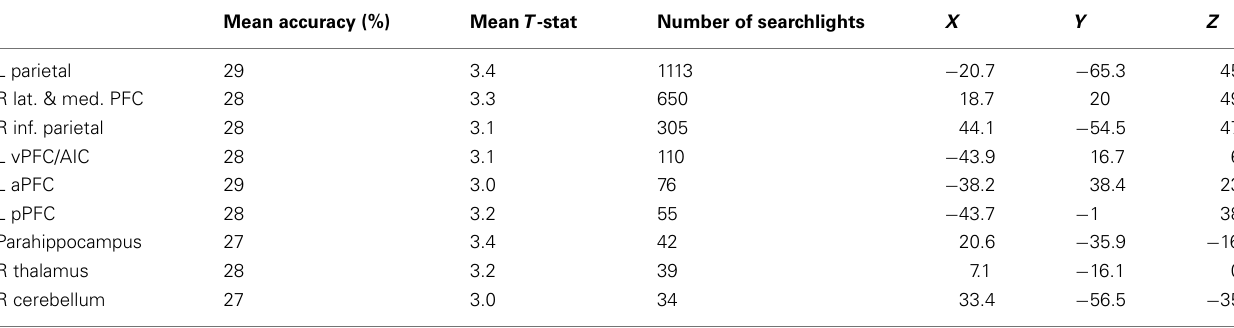
Table 6 |Whole brain decision rule searchlight results.